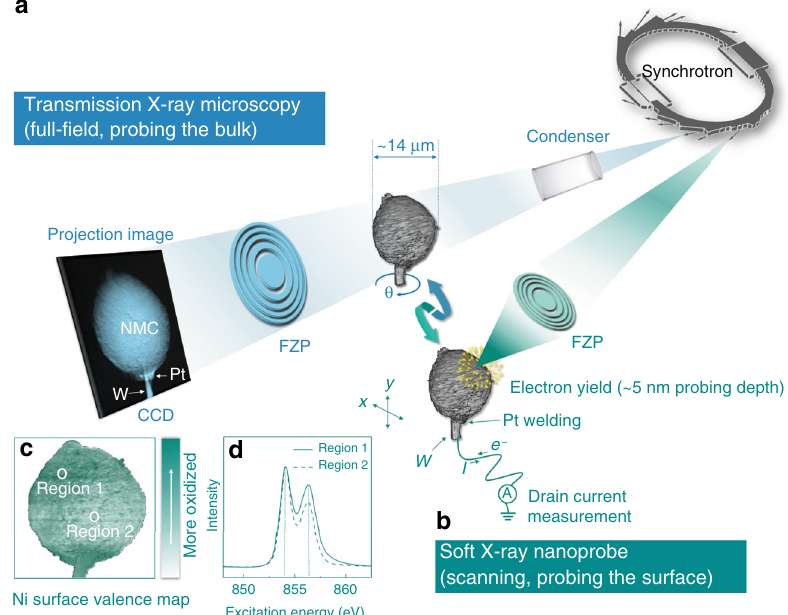
Fig. 1 Schematic illustration of the correlative imaging for an NMC811 secondary particle. In the full- fi eld TXM measurement ( a , light blue color), the transmission images of the particle were acquired as the sample is rotated in a tomographic scan. In the soft X-ray nanoprobe measurement ( b , dark green color), the total electron yield (TEY) signal is recorded by measuring the drain current. Through raster scanning the particle with respect to the focal point, the surface chemical inhomogeneity ( c ) is revealed based on the energy-dependent local TEY signal ( d ) over different surface